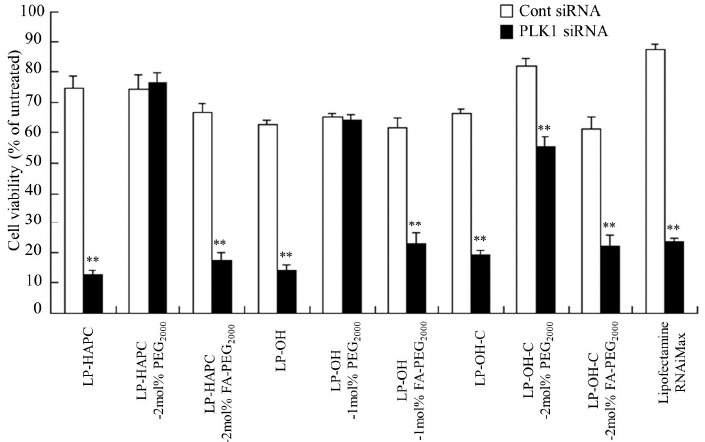
Figure 8. E ff ect of FA-PEG-modification of cationic liposomes on antiproliferative activities 48 h after transfection with FA-PEG-modified PLK1 siRNA lipoplexes into KB cells. As cationic liposomes, LP-HAPC, LP-HAPC-2mol%PEG 2000 , LP-HAPC-2mol%FA-PEG 2000 , LP-OH, LP-OH-1mol%PEG 2000